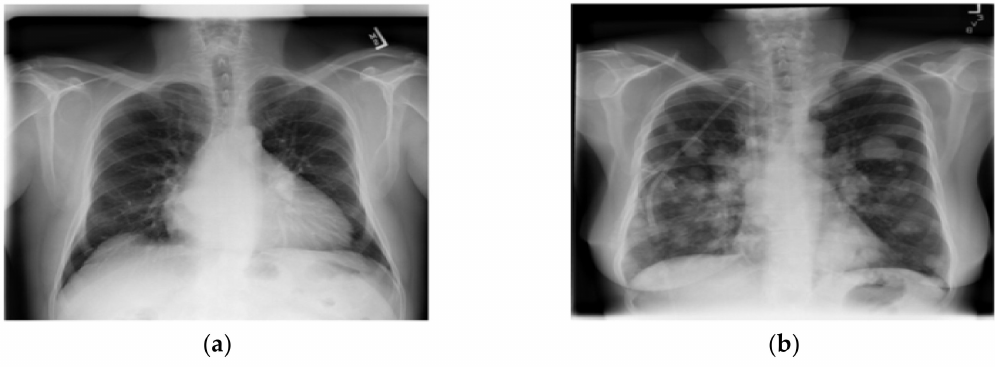
Figure 1. A normal lung ( a ) and a lung disease ( b